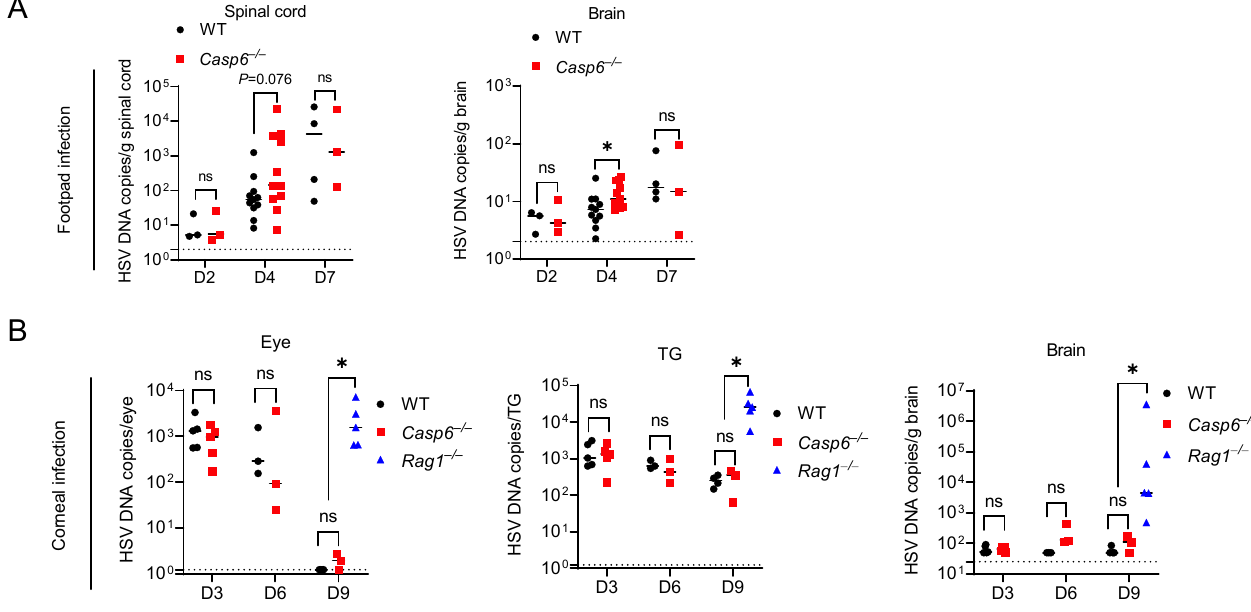
Figure 2. Caspase-6 is partially required to control HSV-1 footpad infection and is not required to control HSV-1 corneal infection. ( A ) WT ( n = 3, 11, 4 for 2, 4, 7 dpi) and Casp6 –/– ( n = 3, 11, 3 for 2, 4, 7 dpi) mice were infected with 10 4 PFU HSV-1 strain NS via footpad injection. HSV-1 DNA copies were determined at 2, 4, and 7 dpi in the spinal cord and brain of WT and Casp6 –/– mice by qPCR. ( B ) WT ( n = 5, 3, 4 for 3, 6, 9 dpi), Casp6 –/– ( n = 5, 3, 3 for 3, 6, 9 dpi), and Rag1 –/– ( n = 5 for 9 dpi) mice were infected with 10 6 PFU HSV-1 strain F via corneal infection. HSV-1 DNA copies were determined in the eye, TG, and brain of WT and Casp6 –/– mice at 3, 6, and 9 dpi and Rag1 –/– mice at 9 dpi by qPCR. Dashed lines indicate detection limit. ns: not significant; * p <